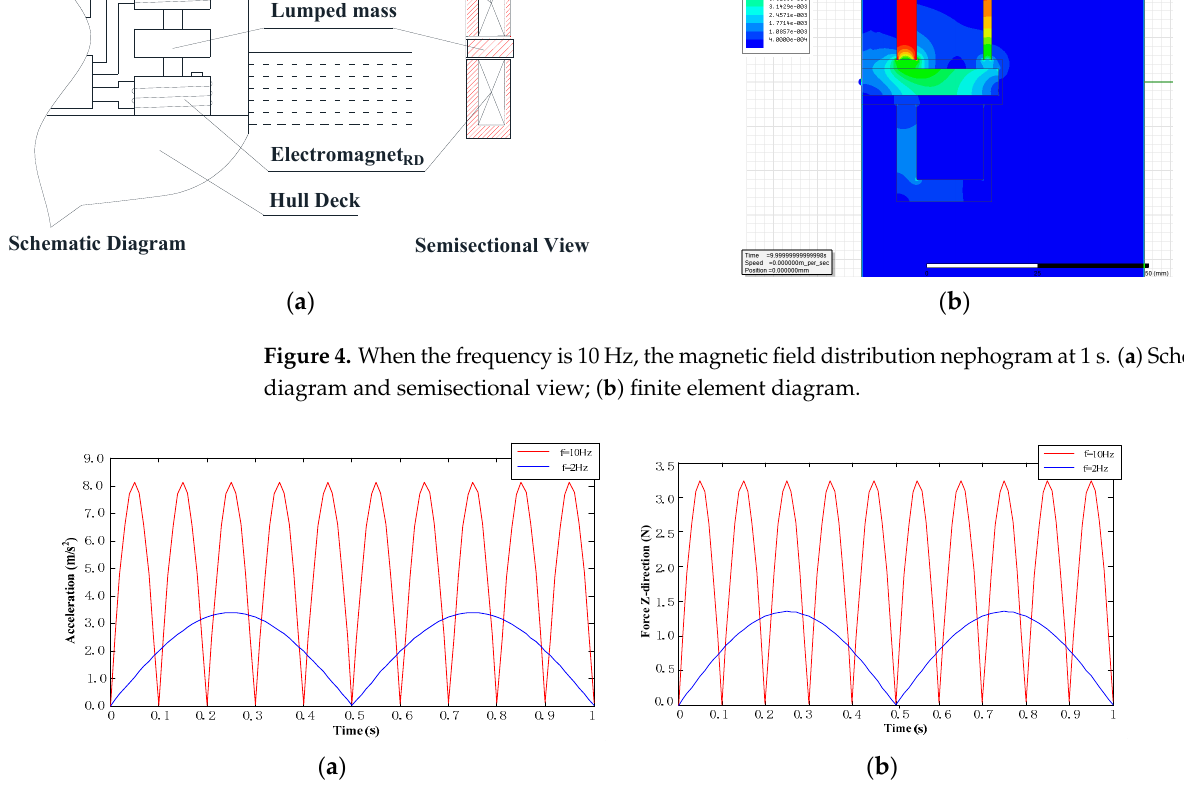
Figure 5. Acceleration and inertia force simulation diagrams of mass block at different frequencies. ( a ) Acceleration diagram; ( b ) inertia force